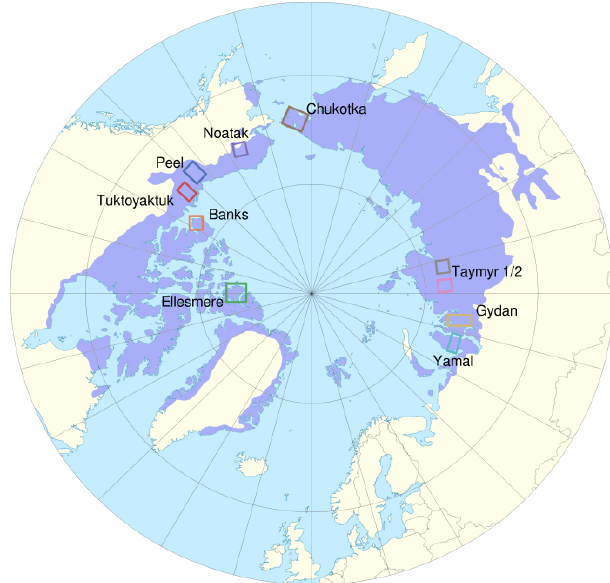
Figure 1. Overview of the study sites. The study sites are distributed around the Arctic with four study sites in northern Canada, one lo- cated in Alaska, and five in Siberia. The purple area shows the zone of continuous permafrost (Brown et al.,